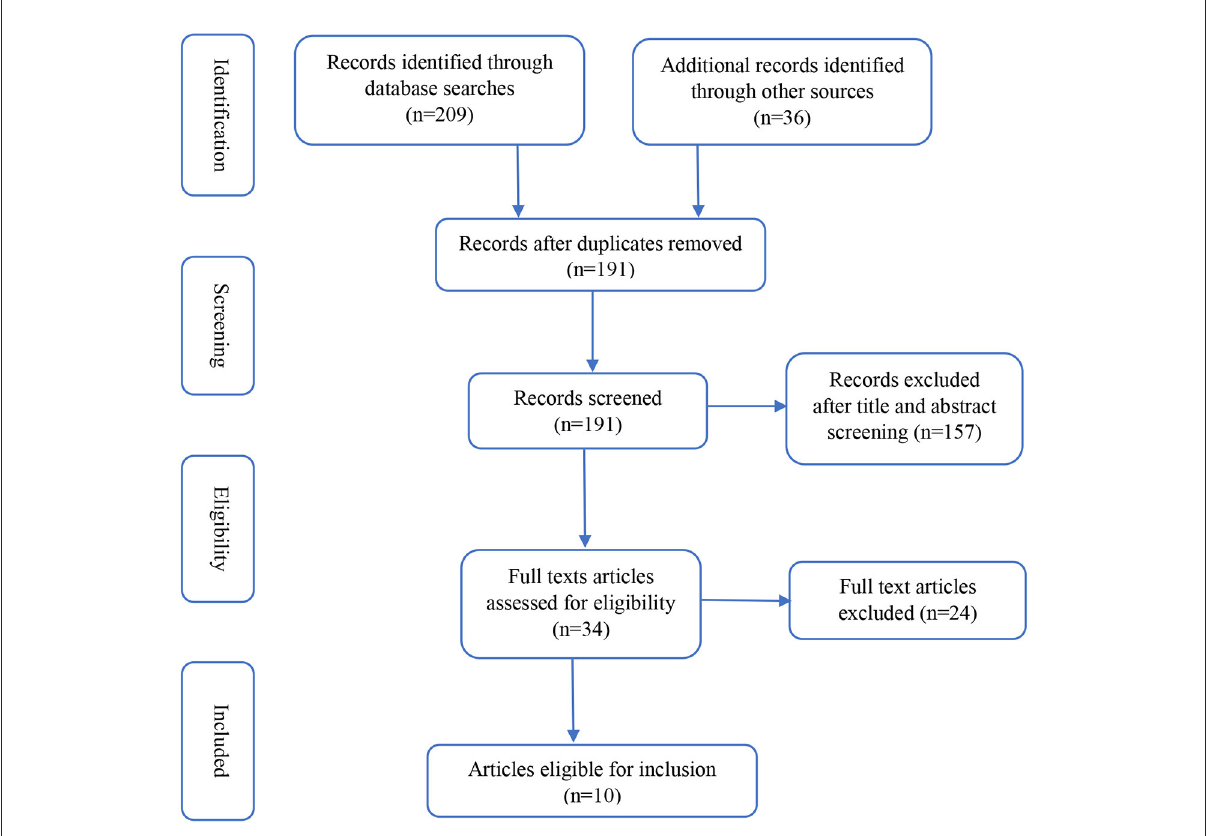
FIGURE1 Results of literature review search